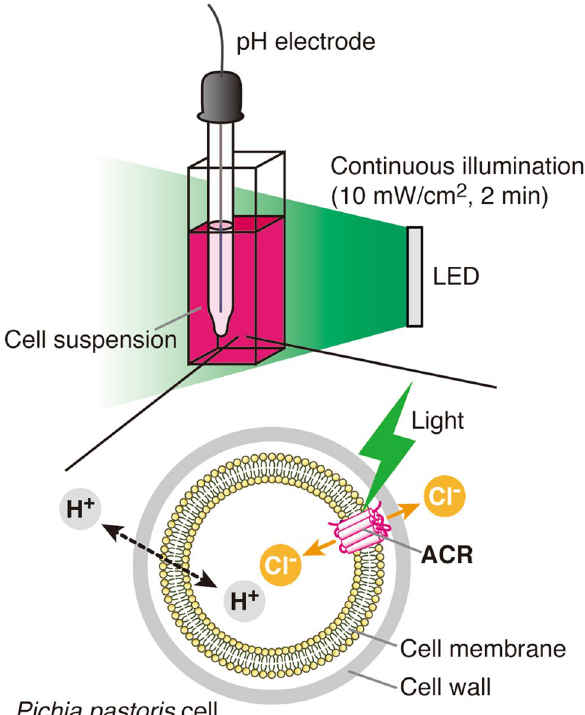
Figure 1. Illustration of the concept of the pH electrode method for measuring anion transport activity of ACRs expressed in yeast P. pastoris cells. In this system, ACRs import anions according their electrochemical potential gradient because the anion concentration outside the cells was kept higher (300 mM) than inside (nearly 0 mM). Therefore, a pH increase will be detected due to the secondary influx of protons to compensate the membrane potential being more negative due to the influx of